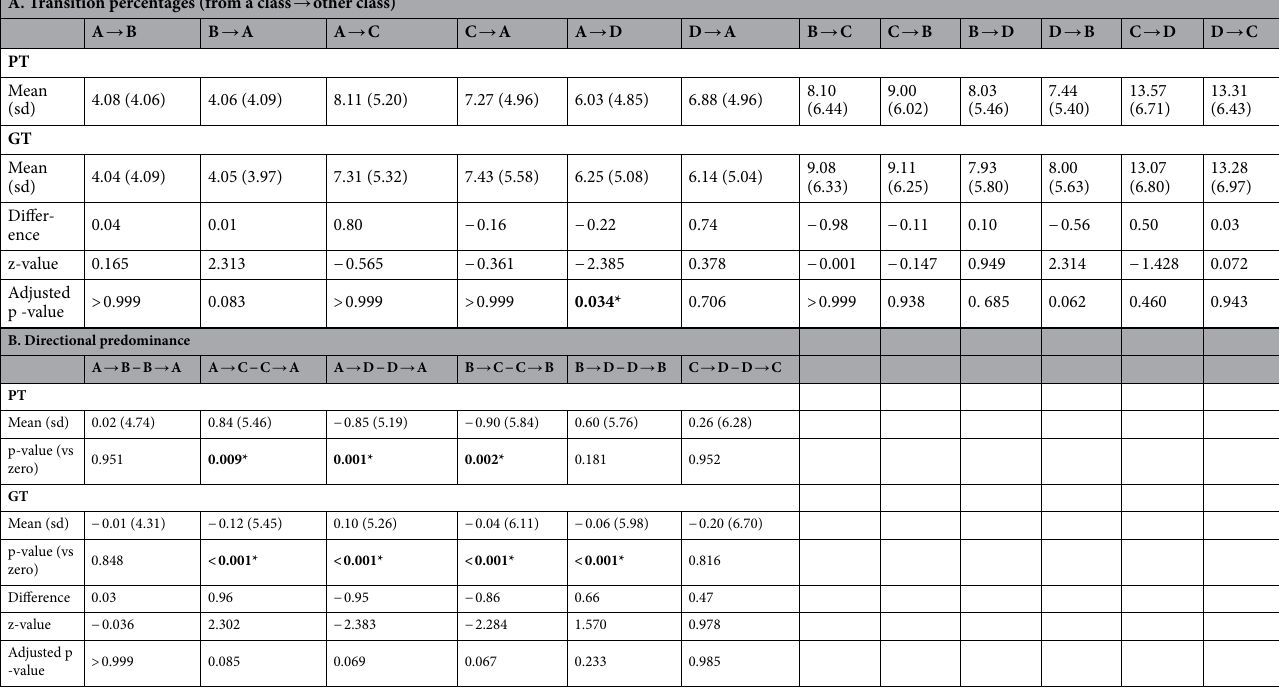
Table 2. Twelve transition percentages and six directional predominance features were obtained from good and poor performers during task performance. Statistical analyses were performed using Mann–Whitney test. After performing Bonferroni–Holm correction for multiple comparisons, significant differences are indicated in asterisk and bold. PT poor performers in task state, GT good performers in task state, mean (standard deviation).